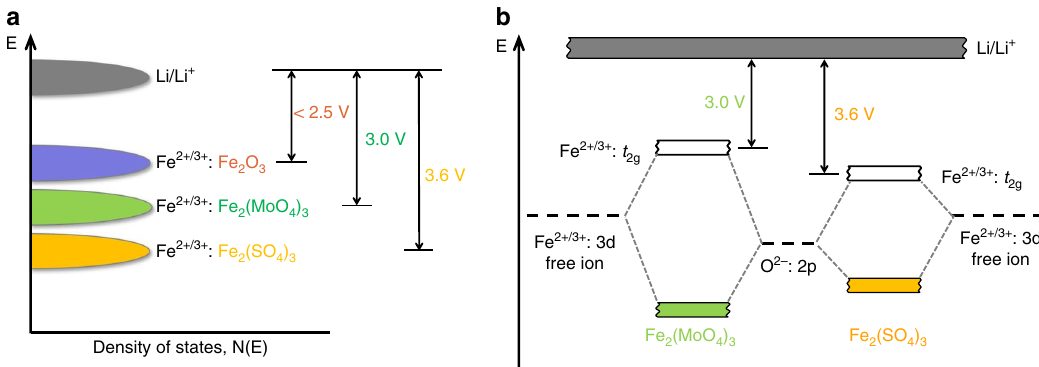
Fig. 4 Role of counter-cations in shifting the redox energies in polyanion oxides. a Lowering of the redox energies of the Fe 2 + /3 + couple and the consequent increase in cell voltage on going from a simple oxide Fe 2 O 3 to a polyanion oxide Fe 2 (MoO 4 ) 3 and then to another polyanion oxide Fe 2 (SO 4 ) 3 with a more electronegative counter-cation S 6 + vs. Mo 6 + , i.e., with a more covalent S – O bond than the Mo – O bond. b Molecular orbital energy diagram illustrating the lowering of the Fe 2 + /3 + redox energy in Fe 2 (SO 4 ) 3 compared to that in the isostructural Fe 2 (MoO 4 ) 3 , due to a weakening of the Fe – O covalence by a more covalent S – O bond than the Mo – O bond through inductive